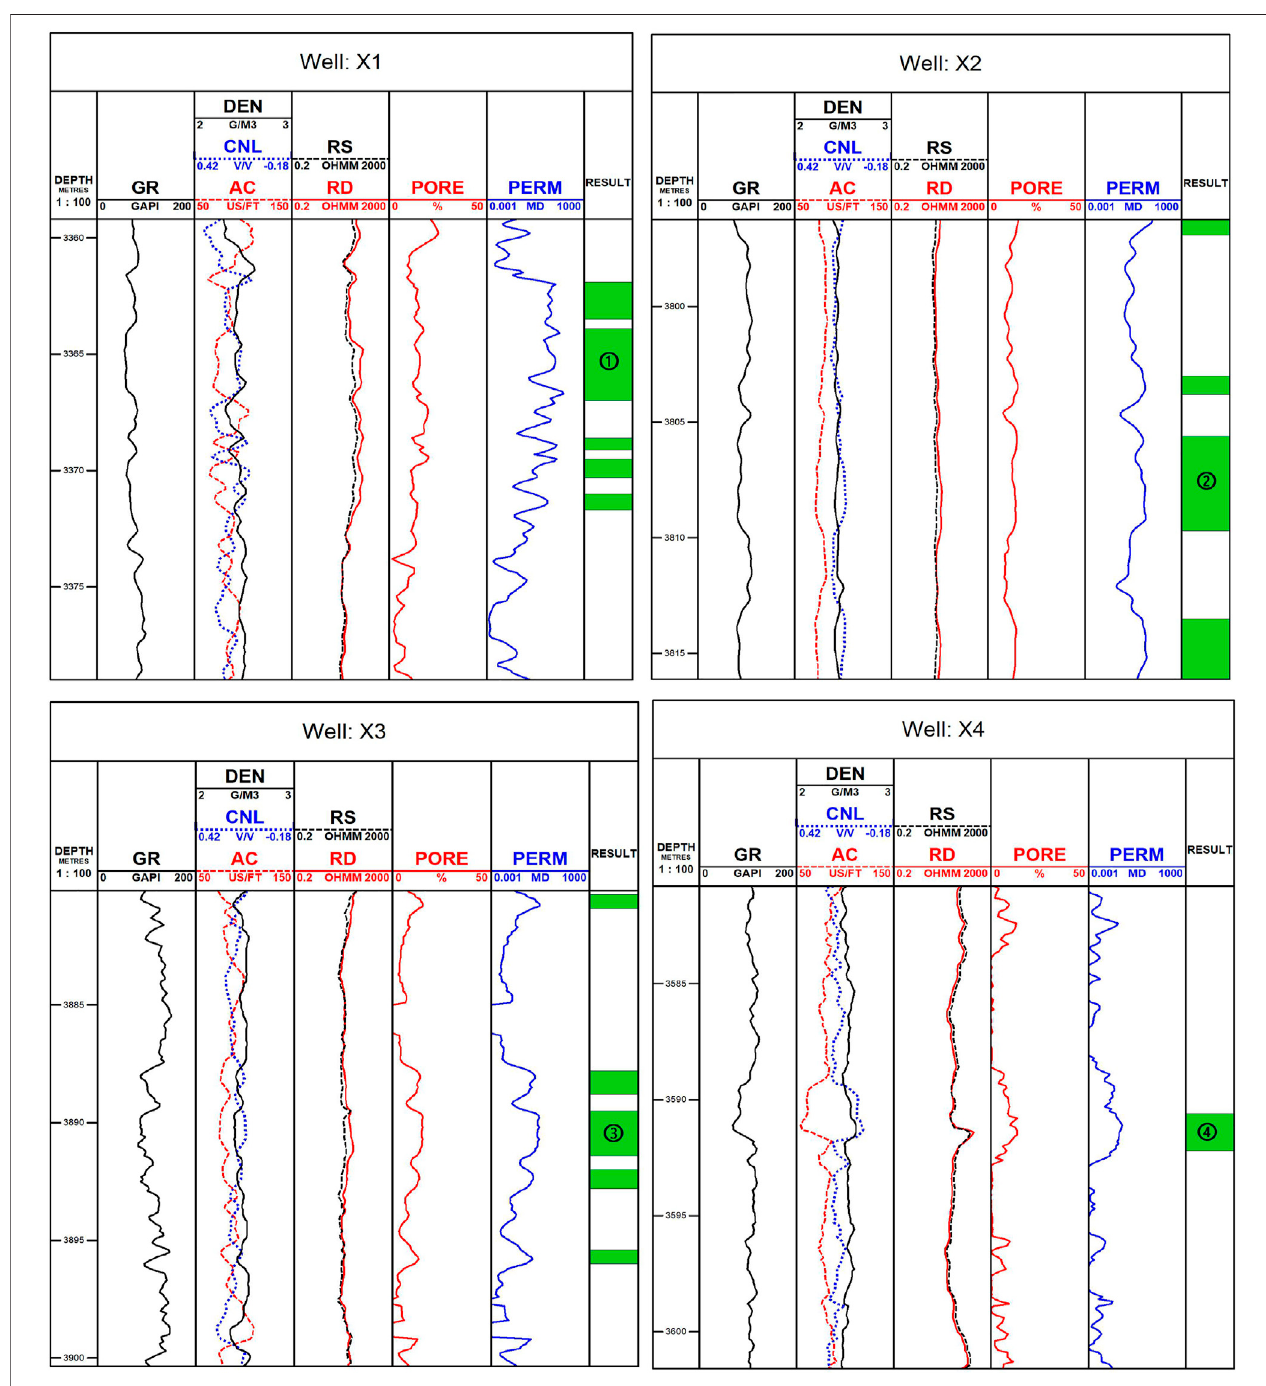
FIGURE 1 | Logging response curve of Es 3 (Gamma ray log (GR), Density log (DEN), Compensated neutron log (CNL), Acoustic log (AC), Shallow lateral resistivity log (RS), Deep lateral resistivity log (RD), Porosity log (PORE), Permeability log (PERM), Fluid properties (RESULT), the same below).